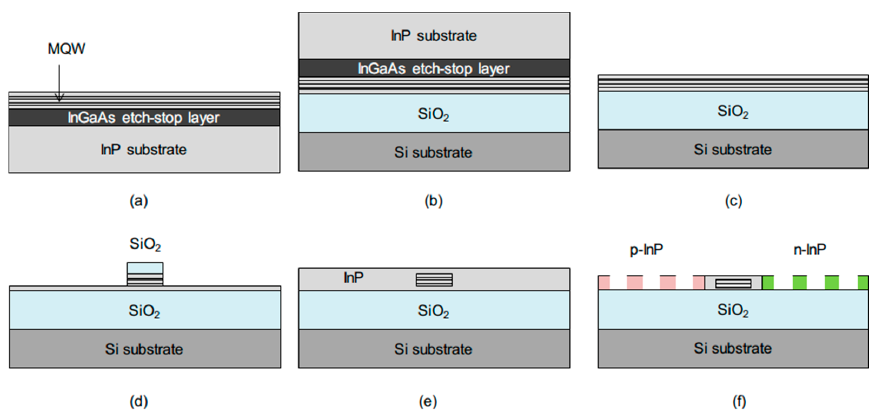
Figure 7. Fabrication procedure for a LEAP laser on Si: ( a ) epitaxial growth of the active layer; ( b ) direct bonding of the InP substrate including the active layer and SiO 2 /Si substrate; ( c ) removal of the InP substrate and sacrificial layer; ( d ) removal of the active layer except for the active region; ( e ) buried regrowth; ( f ) selective doping and air hole fabrication.